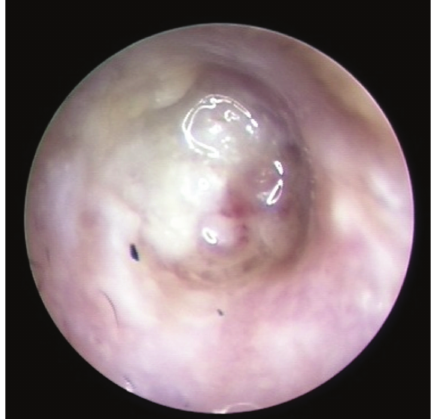
Figure 2: The first examination of the left ear in Case 2. Otorrhea and squamous debris with irregularity and granulation of the posterior ear canal down to the tympanic membrane was